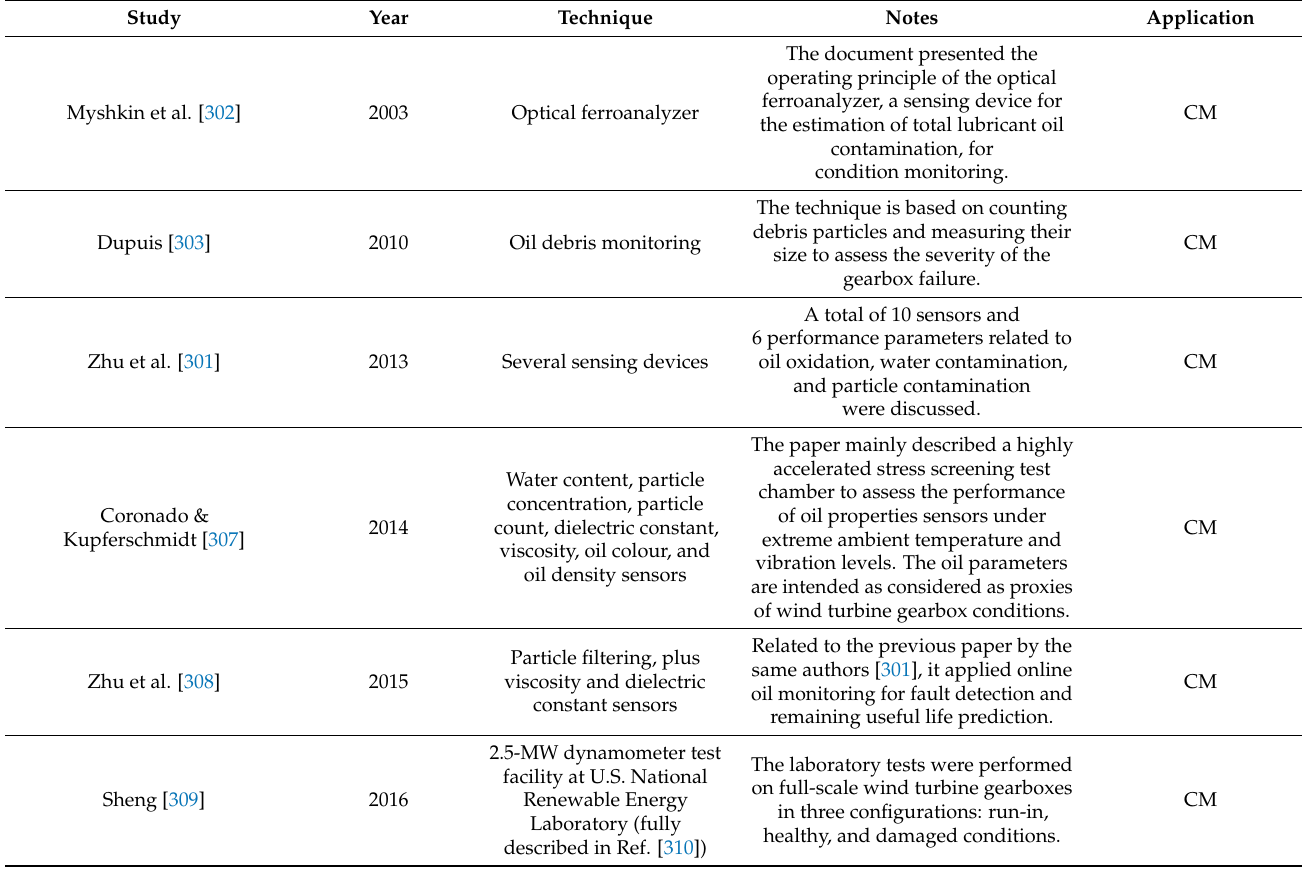
Table 10. Some common typologies of oil monitoring strategies encountered in the scientific